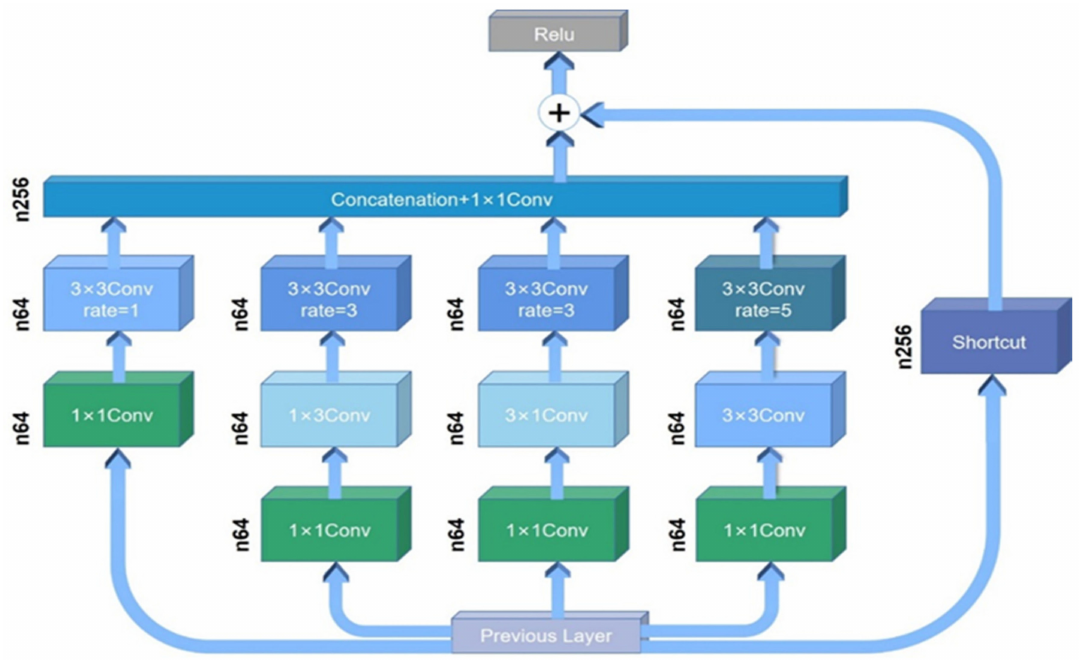
Figure 2. The architecture of the RFB-s module